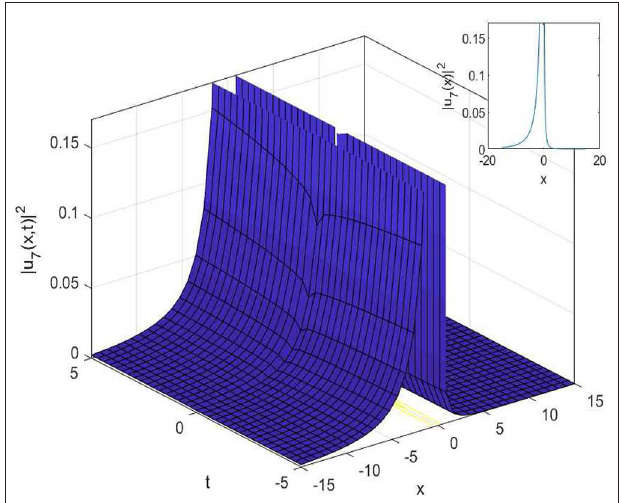
FIGURE 7 | 3D, 2D, and contour surfaces of Equation (38) where α 0.3, c 1 0.5, c 2 0.2, κ = = = =